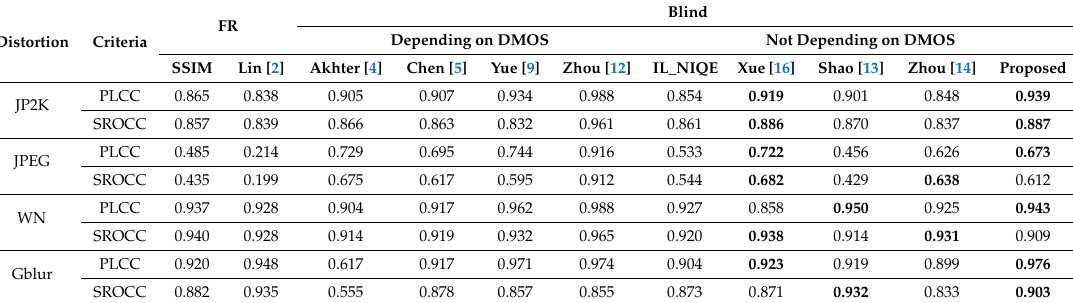
Table 2. Performance of nine methods for each individual distortion